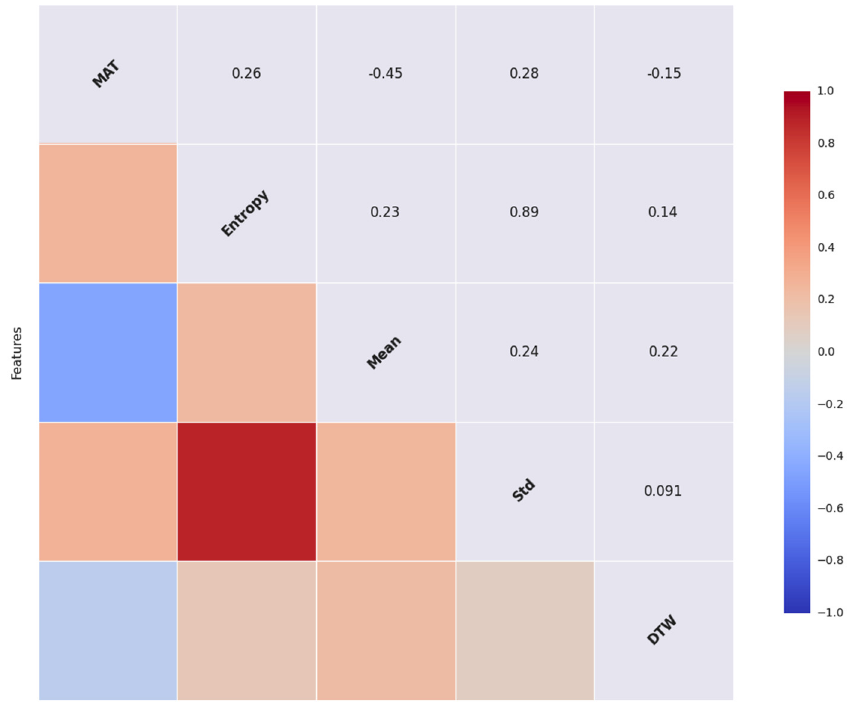
Fig 3. Feature Set Correlation Matrix. MAT refers to marital satisfaction; Mean refers to States mean; Std refers to States standard deviation.